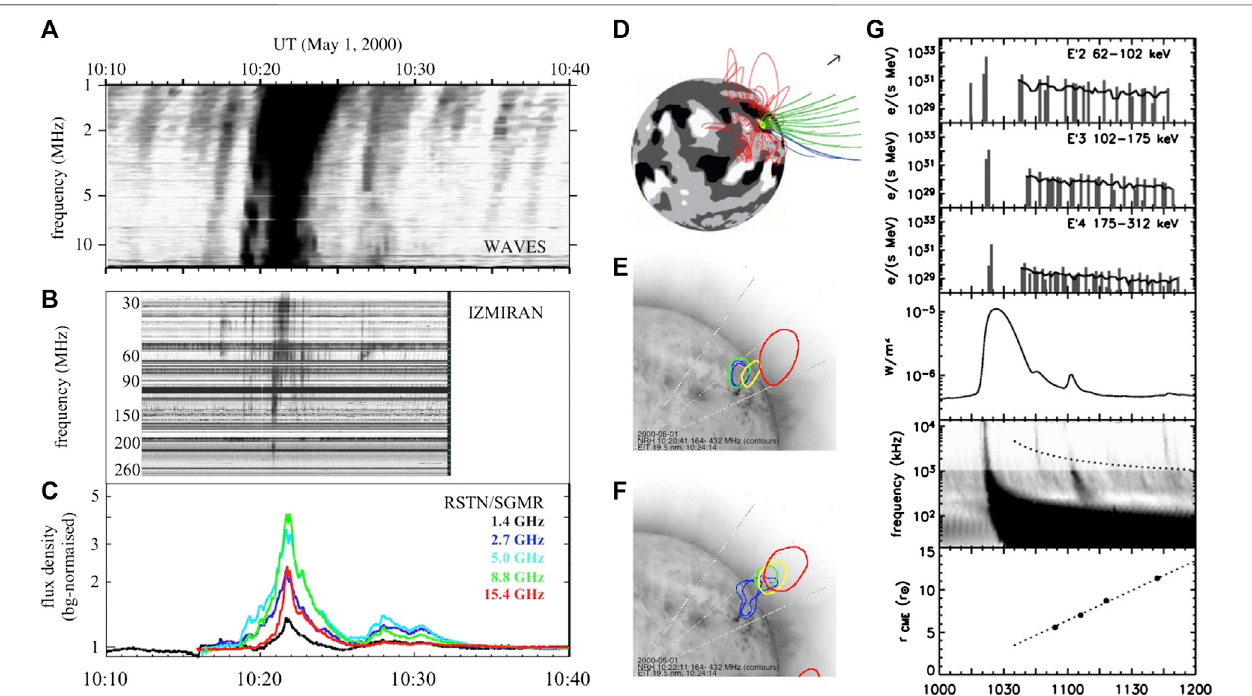
FIGURE 1 | Radio observations, magnetic fi eld mapping, and electron release modeling during the May 1, 2000 fl are. Left column: Dynamic spectra at decameter ( (A) ; Maia and Pick, 2004, ©AAS) and meter wavelengths ( (B) ; IZMIRAN, https://www.izmiran.ru/stp/lars/; fi gure provided by I. Chertok and R. Gorgutsa) and time historiesatdiscretemicrowavefrequencies( (C) ;dataprovidedbyNGDC,https://www.ngdc.noaa.gov/stp/space-weather/solar-data/solar-features/solar-radio/rstn-1- second/). Middle column: synoptic map of the photospheric magnetic fi eld and fi eld lines extrapolated using a PFSS model ( (D) ; Wang et al., 2006b, ©AAS) and iso-intensitycontoursoftheradiosourcesduringtwotypeIIIburstsoverlaidonanEUVimageat19.5nmwavelength( (F) ;afterKleinandPosner,2005,©ESO). Thetwo radial lines through thediskcenterdelimittheCMEasreported byKahler et al.(2001).Right column (G) :Injection functionsofelectrons in threechannelsofACE/EPAM, comparedwiththesoftX-raytime pro fi le(thirdfrombottom),thedynamicradiospectrumintherange14MHz – 120kHz(frequency increasingfrombottom totoponthe vertical axis), and the height-time plot of the CME (bottom). From Agueda et al. (2008), ©AAS. Figures reproduced with permission.